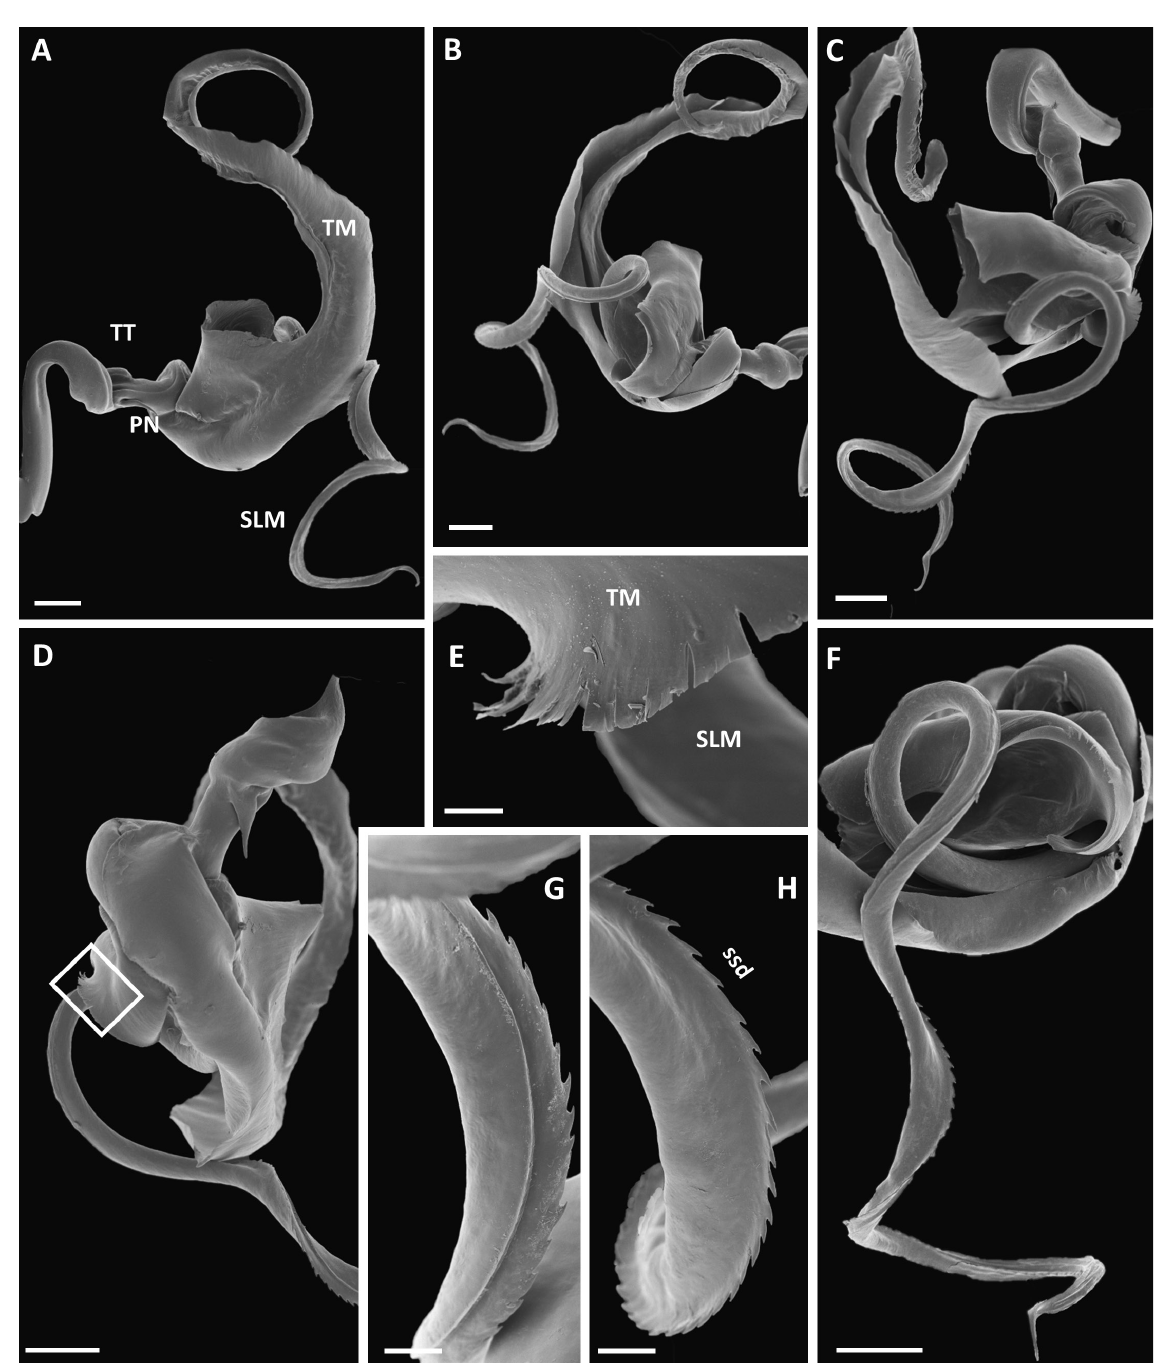
Fig. 49. Notogallanus mastacembalus gen. et sp. nov., holotype, ♂ (VMNH110632), left gonopod telopodite. A . Anterior view. B . Posterior view. C . Subventral view. D . Subdorsal view. E . Close-up of framed area of D, showing telomeral ‘skirt’ at exit of solenomere. F . Submesal view. G–H . close- ups of serrate part of solenomere. Abbreviations: PN = post-torsal narrowing; SLM = solenomere; ssd = solenomeral ‘saw teeth’; TM = telomere; TT = torsotope. Scale bars: A–D, F = 0. 2 mm; E = 0.02 mm; F–G = 0.05